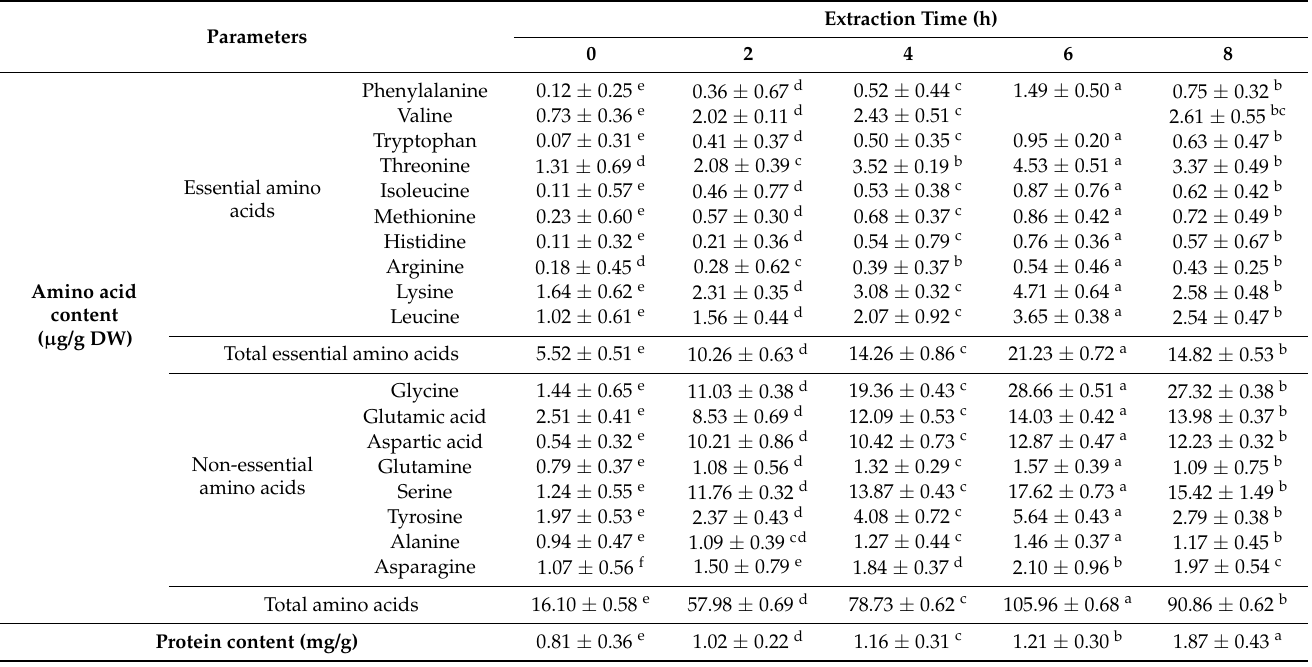
Table 2. The effect of extraction time on the amino-acid content and protein content of SPE in Eri strains.